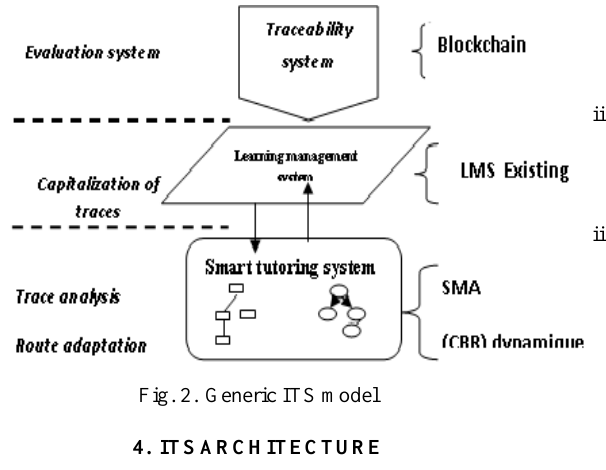
Fig. 2. Generic ITS